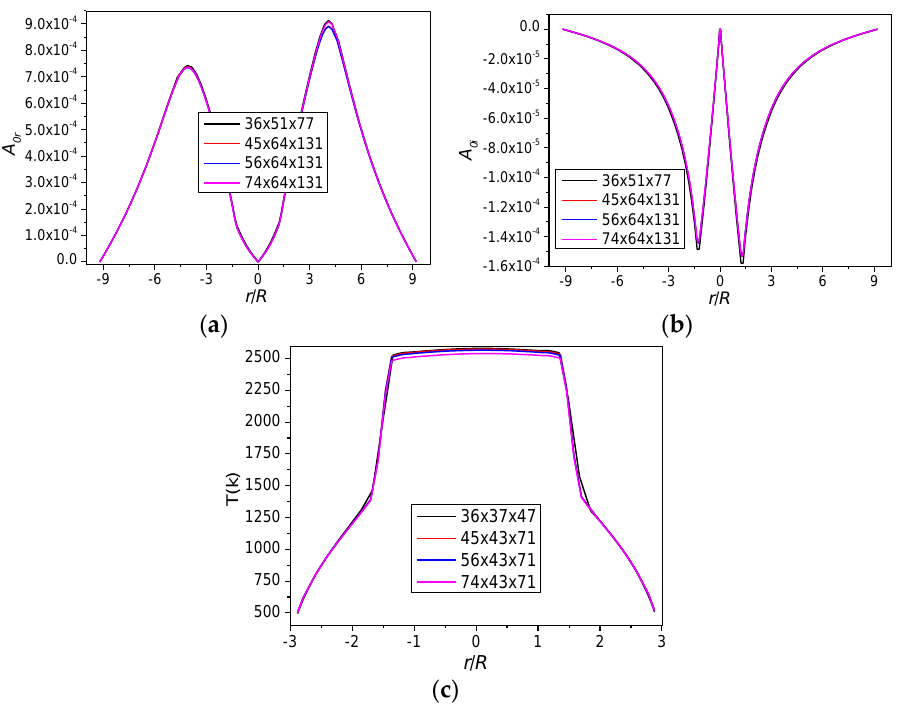
Figure 4. A 0 and T profiles in r-direction for different meshes. ( a ) real part of magnetic potential, A 0 r ; ( b ) imaginary part of magnetic potential, A 0 i ; ( c ) temperature, T .